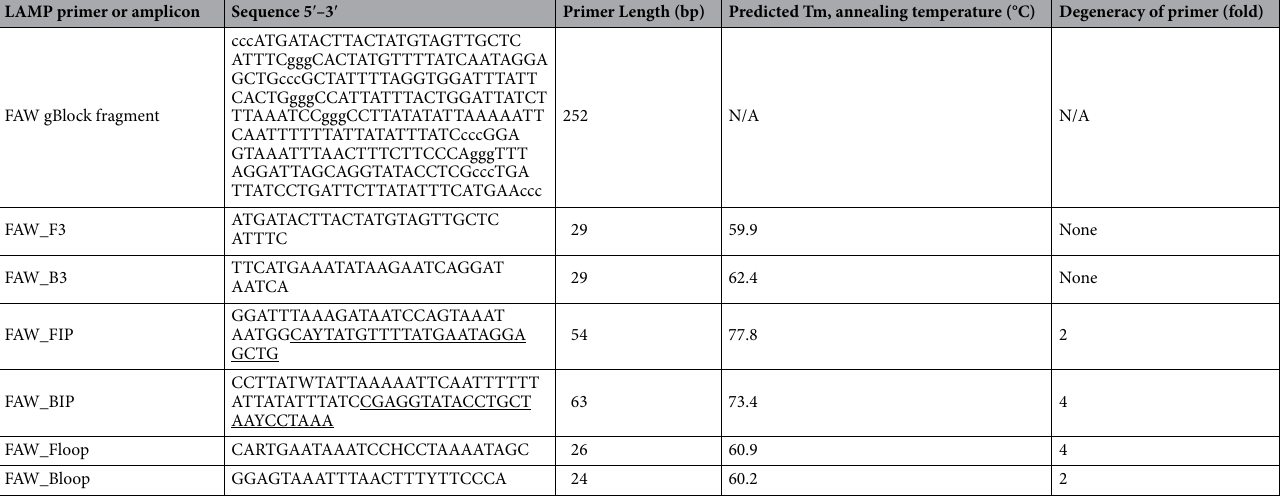
Table 1. FAW COI LAMP primer and amplicon sequences (gBlock) and parameters. The F2 and B2 primer regions of FIP and BIP are underlined. Lowercase letters in the gBlock indicate extra “ccc” or “ggg” added between LAMP primer sites to increase the overall Tm of the